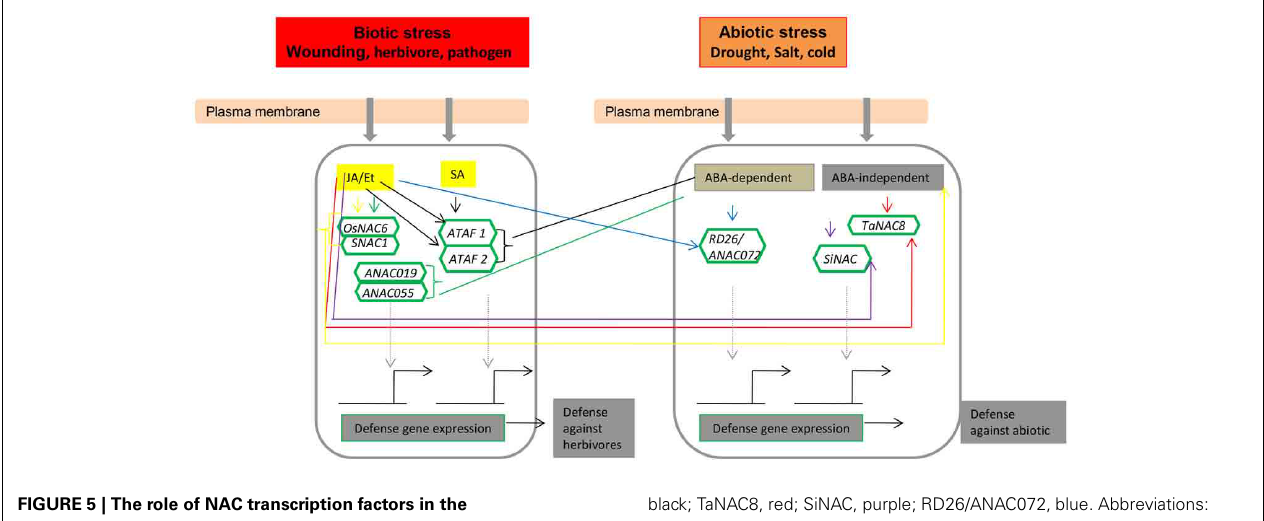
black; TaNAC8, red; SiNAC, purple; RD26/ANAC072, blue. Abbreviations: ABA, abscisic acid; ANAC, Arabidopsis thaliana NAC; JA, jasmonic acid; Et, ethylene; and SA, salicylic